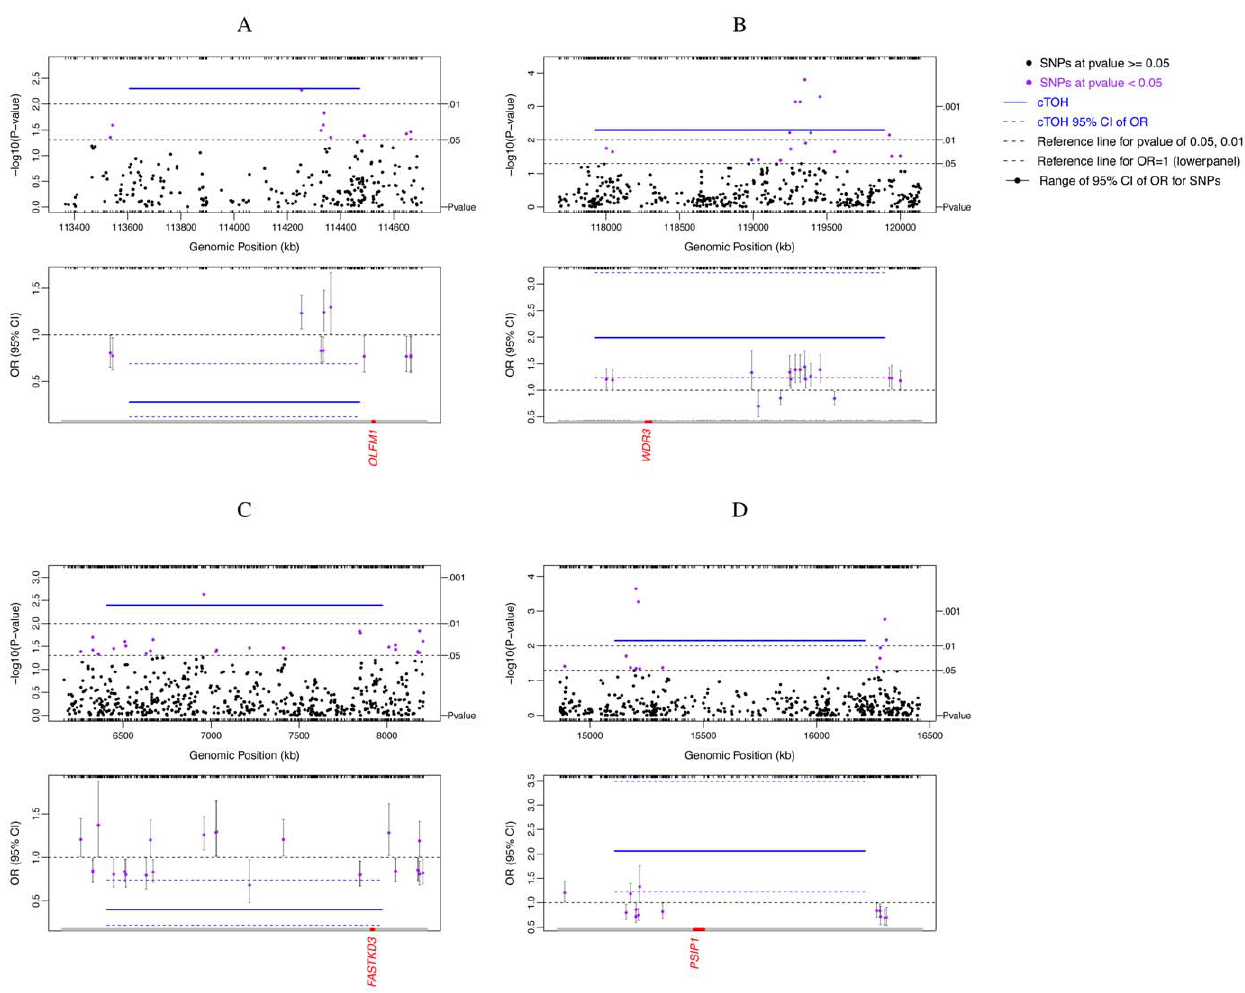
Figure 3. Lung cancer-associated cTOH1, cTOH2, cTOH5 and cTOH7 regions Single SNP association analysis was performed (independently of TOH analysis), after which the SNP association was compared to significant TOHs obtained with TOH analysis. The significant lung cancer-associated single SNPs, and TOH’s namely cTOH1, cTOH2, cTOH5, and cTOH7, and their respective 95% CI are shown. The significant lung cancer association of aTOHs and SNPs in the region (top panel) and corresponding risk as odds ratios (lower panel) are shown in panels A–D. Below the lower panels are candidate genes which were prioritized after testing for association between lung cancer and differential expression of each of the genes within each significant TOH + / 2 250 kb TOH, stratified by smoking status (at p , 0.0001; see Methods